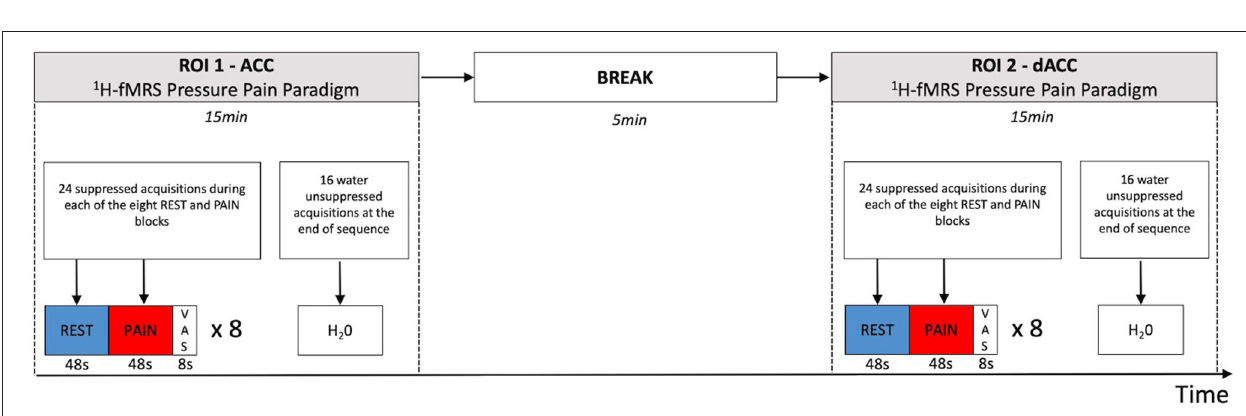
< 0.1 ppm and (4) fit quality (Q) < 2.5. No spectra had to